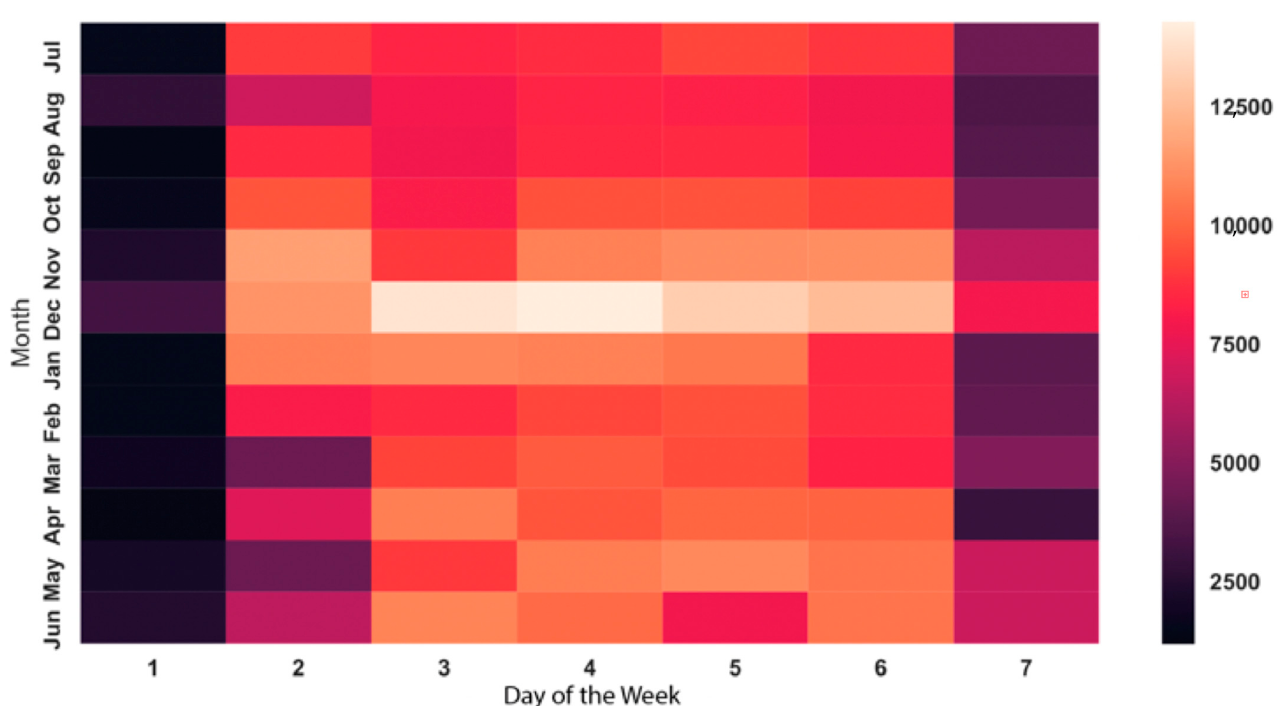
Figure 5. Comparison of the mean number of locker spaces per month between all parcels picked up and 30% of parcels not picked up (Density 1.0).